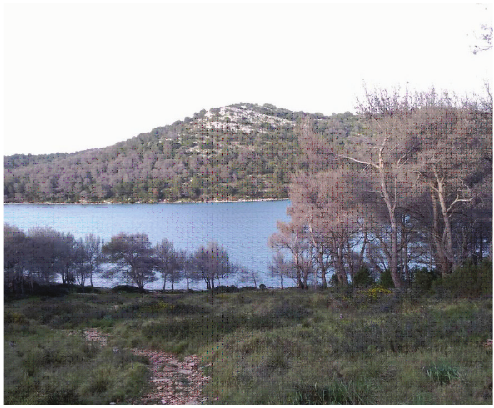
figUre 4. Dendrolimus pini outbreak in 2017 around Salt Lake, Telašćica Nature Park, Dugi